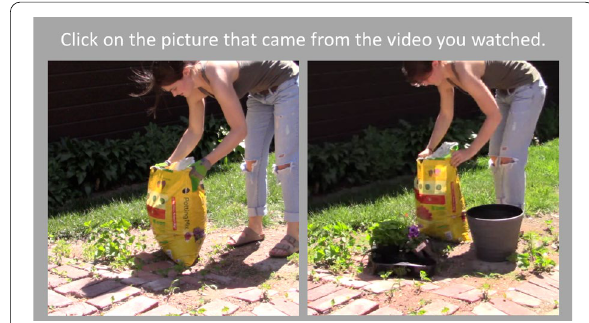
Fig. 2 An example recognition memory test trial. Participants were asked to select the picture that came from the video they watched. The target image is on the right, and the distractor image is on the left in this